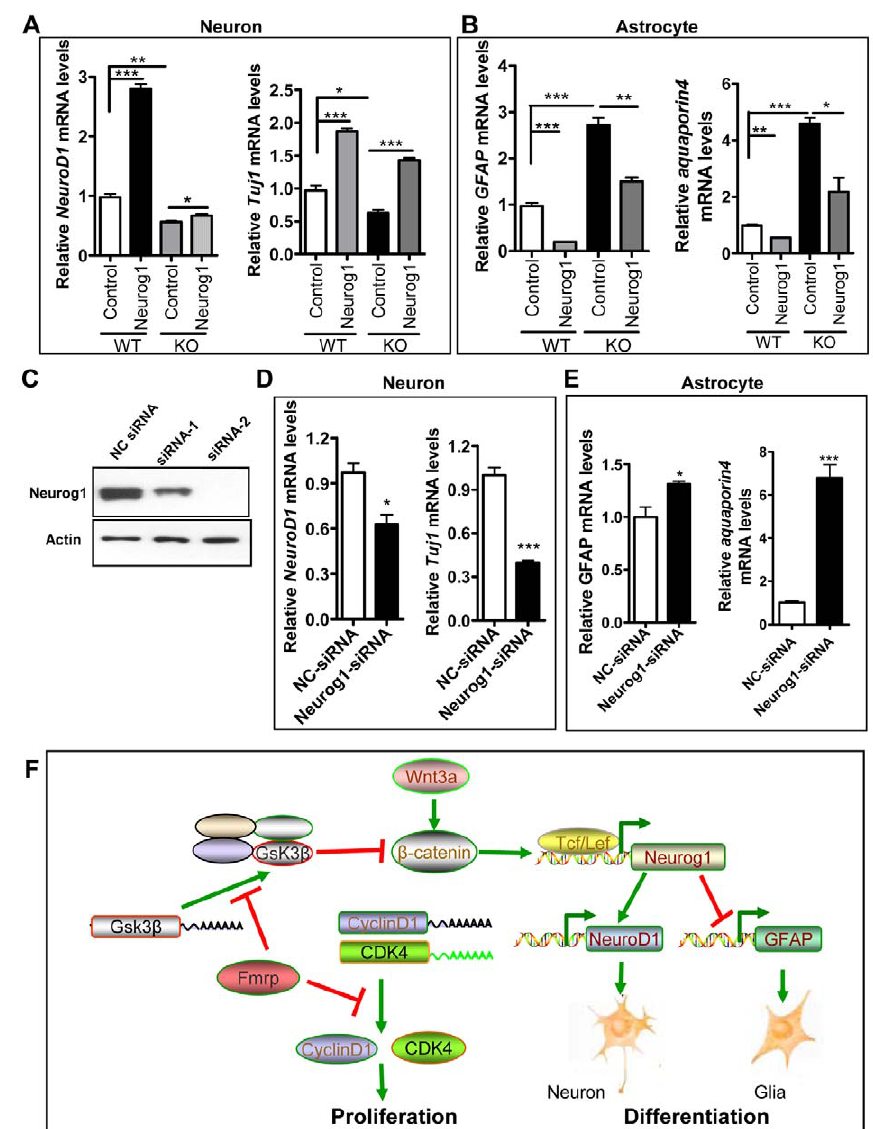
Figure 7. Neurog1 regulates the fate specification of aNPCs. (A,B) Exogenously expressed Neurog1 could rescue the neuronal and astrocyte differentiation deficits of Fmr1 KO aNPCs, as assessed by real-time PCR of neuron ( NeuroD1 and Tuj1 ) and astrocyte ( GFAP and aquaporin4 )-specific gene expression (n=3; Control, pCDNA3 empty vector) (C) Neurog1-siRNA could specifically reduce the Neurog1 protein expression from a co- transfected Neurog1 expression vector. siRNA-2 was more effective at reducing Neurog1 protein expression, and was therefore used in all functional tests. NC-siRNA: Nonsilencing Control siRNA. (D,E) Acute knockdown of Neurog1 expression in aNPCs led to reduced neuronal differentiation (D), but increased astrocyte differentiation (E) in WT aNPCs, as assessed by real-time PCR of cell lineage-specific genes (n=3). Cell differentiation was assessed by the relative mRNA levels of NeuroD1 (A and D, left), Tuj1 (A and D, right), GFAP (B and E, left), and aquporin4 (B and E, right). GAPDH mRNA levels were used as an internal control for all real-time PCR analyses, unless stated otherwise. (F) Model of Fmrp functions in adult neurogenesis. By regulating the translation of cyclin D1 and CDK4, Fmrp controls the proliferation of aNPCs. By controlling the translation of GSK3 b , Fmrp maintains the proper intracellular levels of b -catenin and Wnt signaling. Upon differentiation, b -catenin positively regulates the expression of Neurog1, which promotes neuronal differentiation and represses glial differentiation. All data are shown as mean 6 SEM, and Student’s t-test was used for all the analyses. *, p , 0.05; ***, p ,